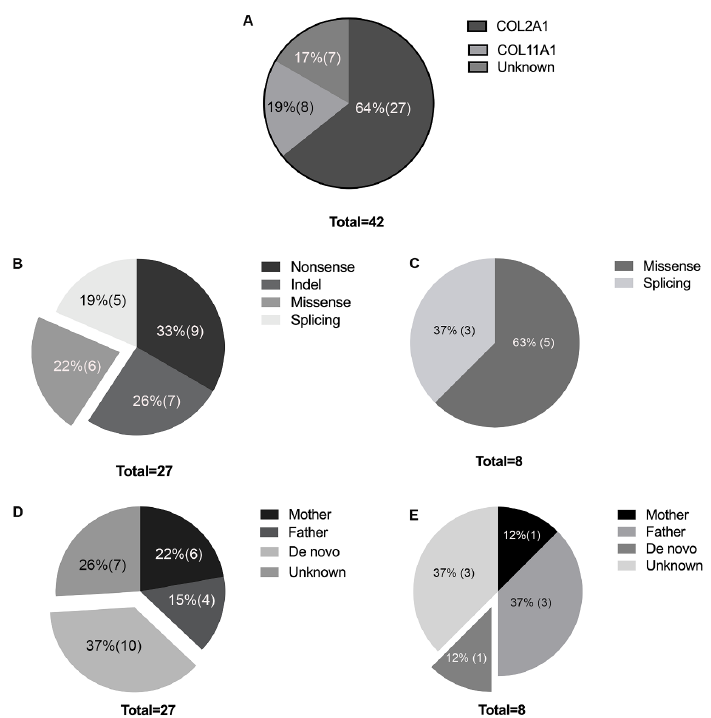
Figure 3. ( A ) Mutation spectrum of the study cohort. ( B ) Composition of COL2A1 mutation types. ( C ) Composition of COL11A1 mutation types. ( D ) Mutation inheritance of the COL2A1 gene. ( E ) Mutation inheritance of COL11A1 .